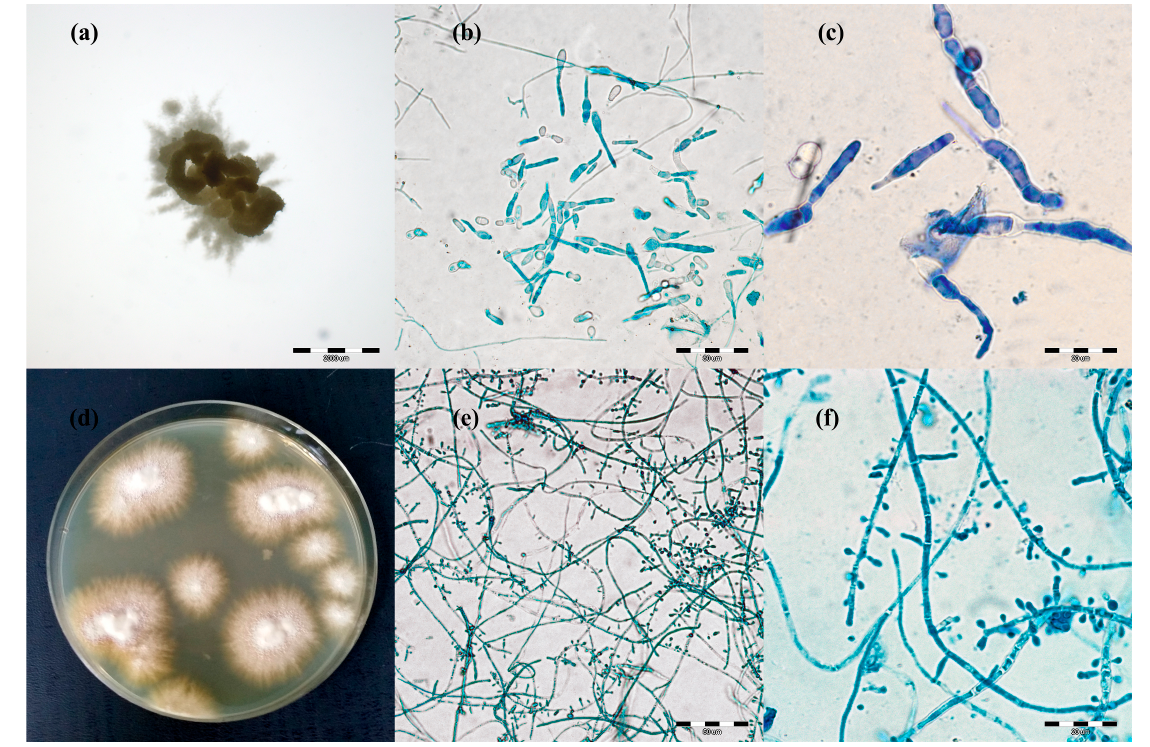
Figure 2. Micro- and macromorphology of two species of dermatophytes isolated from one outbreak of lesions from cattle. Legend: after three passages, two separate pure dermatophyte cultures were obtained: ( a – c ), Trichophyton verrucosum ; ( a ), macromorphology after 21 days of incubation on Sabouraud medium at magnification 4 × ; ( b ), micromorphology after staining with lactophenol blue at magnification 400 × ; ( c ), at magnification 1000 × ; ( d – f ), Trichophyton benhamiae ; ( d ), micromorphology (obverse); ( e ), micromorphology after staining with lactophenol blue at magnification 400 × ; ( f ), at magnification 1000 × (pictures taken with light microscopy Olympus